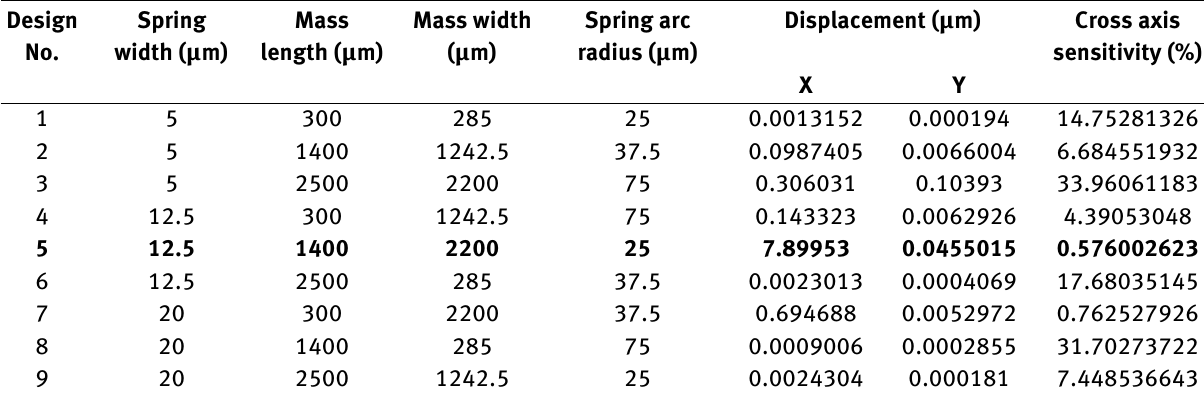
Table 2: Design parameter and their result Design